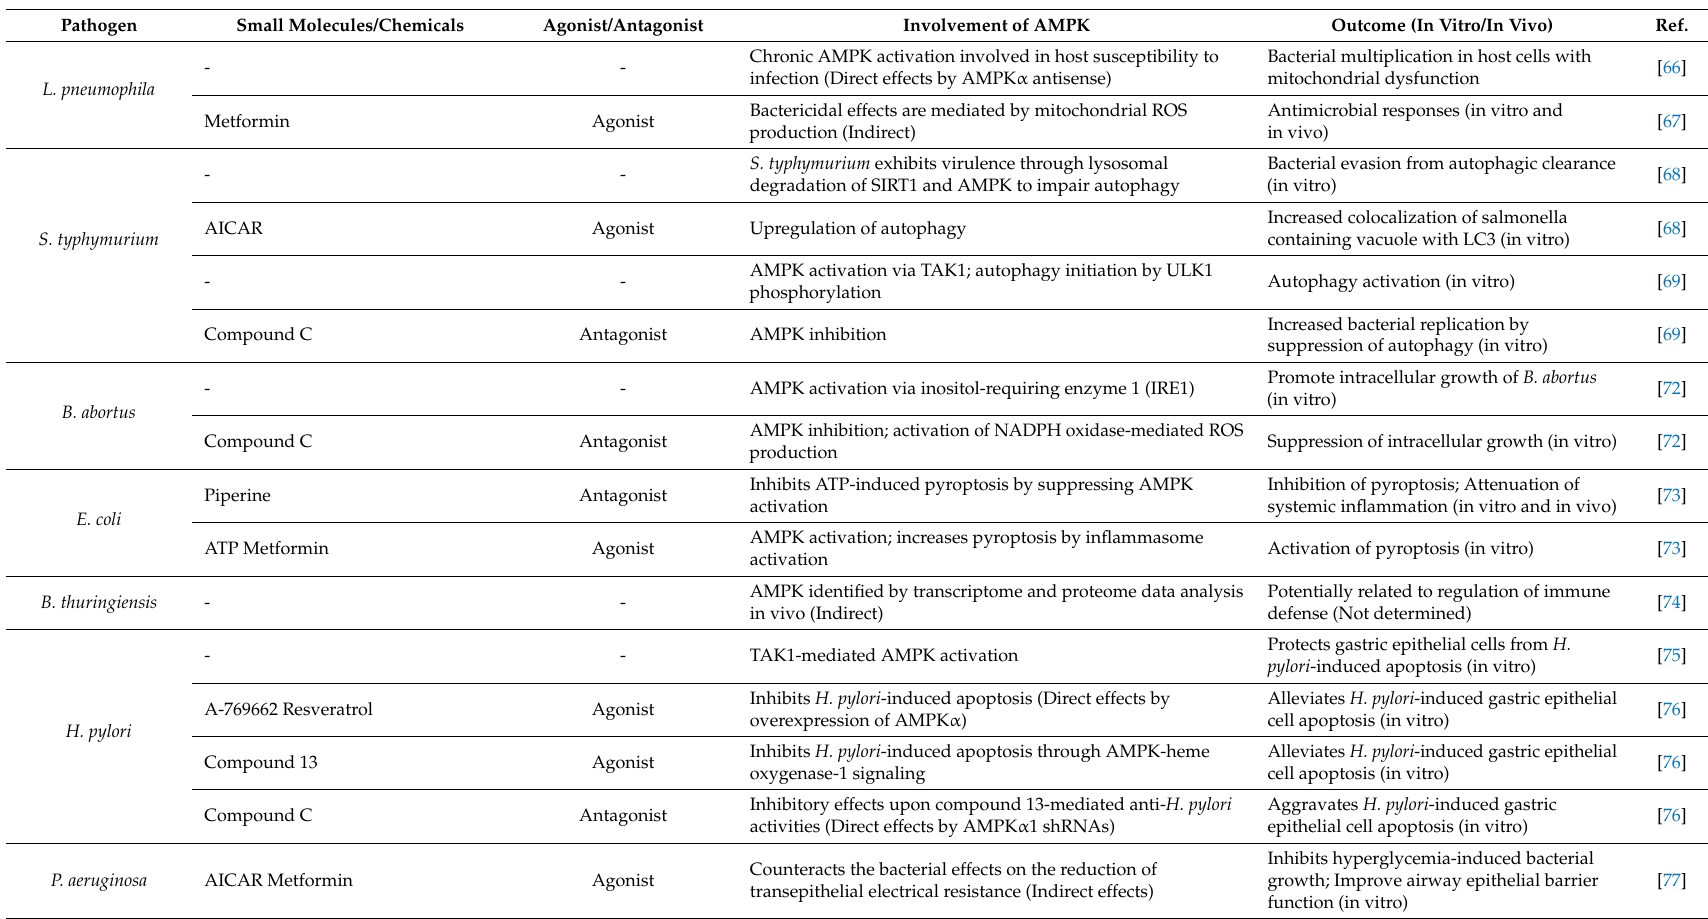
Table 3. The roles of AMPK in bacterial